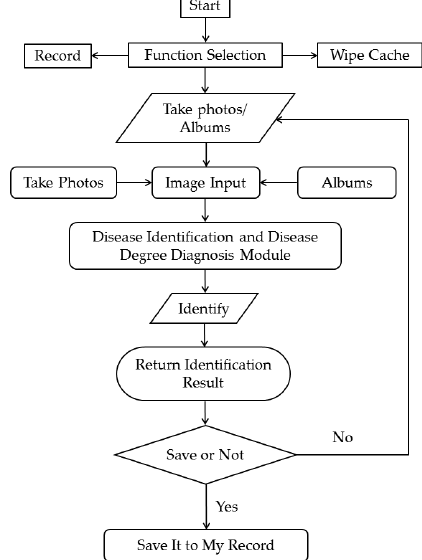
Figure 10. The flow chart of the